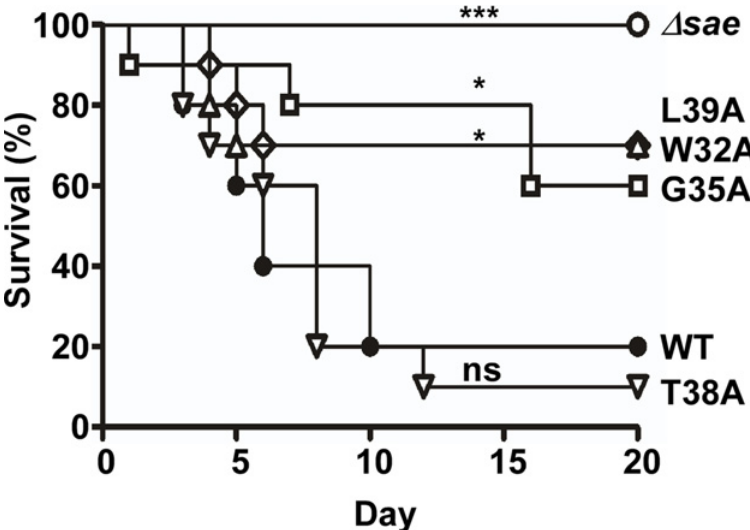
Fig 9. The linker peptide mutants exhibiting lower kinase activity show attenuated virulence in a murine model of infection. The test strains were grown in TSB until exponential growth phase; then the test strains (10 7 cfu) were administered into Balb/c mice via retro-orbital route. The infected mice were observed for 20 days. The differences in the survival were analyzed by Log-rank (Mantel-Cox) test. * , p < 0.05; *** , p < 0.001; ns, not significant. The experiment was repeated, and similar results were